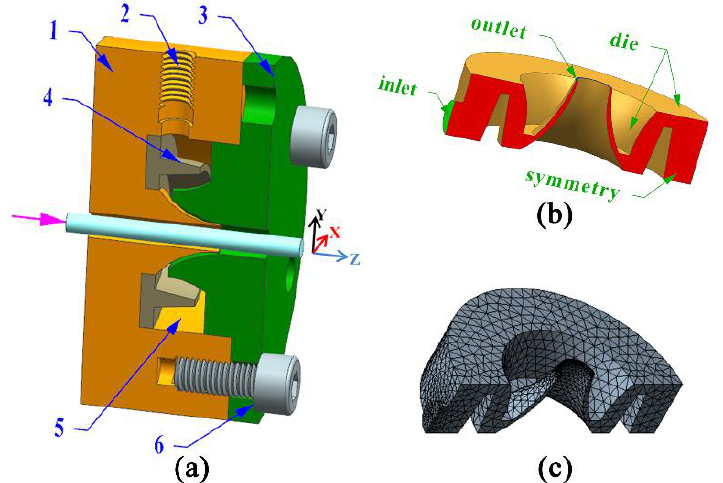
Figure 3. Geometric model and finite element model of the double-chamber die. ( a ) Geometric model of the double-chamber gas-assisted die, 1 — Connection module, 2 — Gas inlet, 3 — Die ring, 4 — Gas diffuser plate, 5 — Double gas distribution chamber; 6 — Connecting screw; ( b ) Geometry of the double gas distribution chamber; ( c ) Finite element mesh model of the double gas distribution